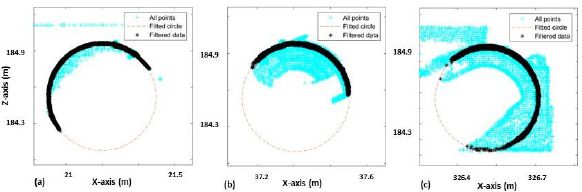
Figure 17. Sample locations with positive DFT matching and roller detection. Several outlier points can be seen that were filtered.